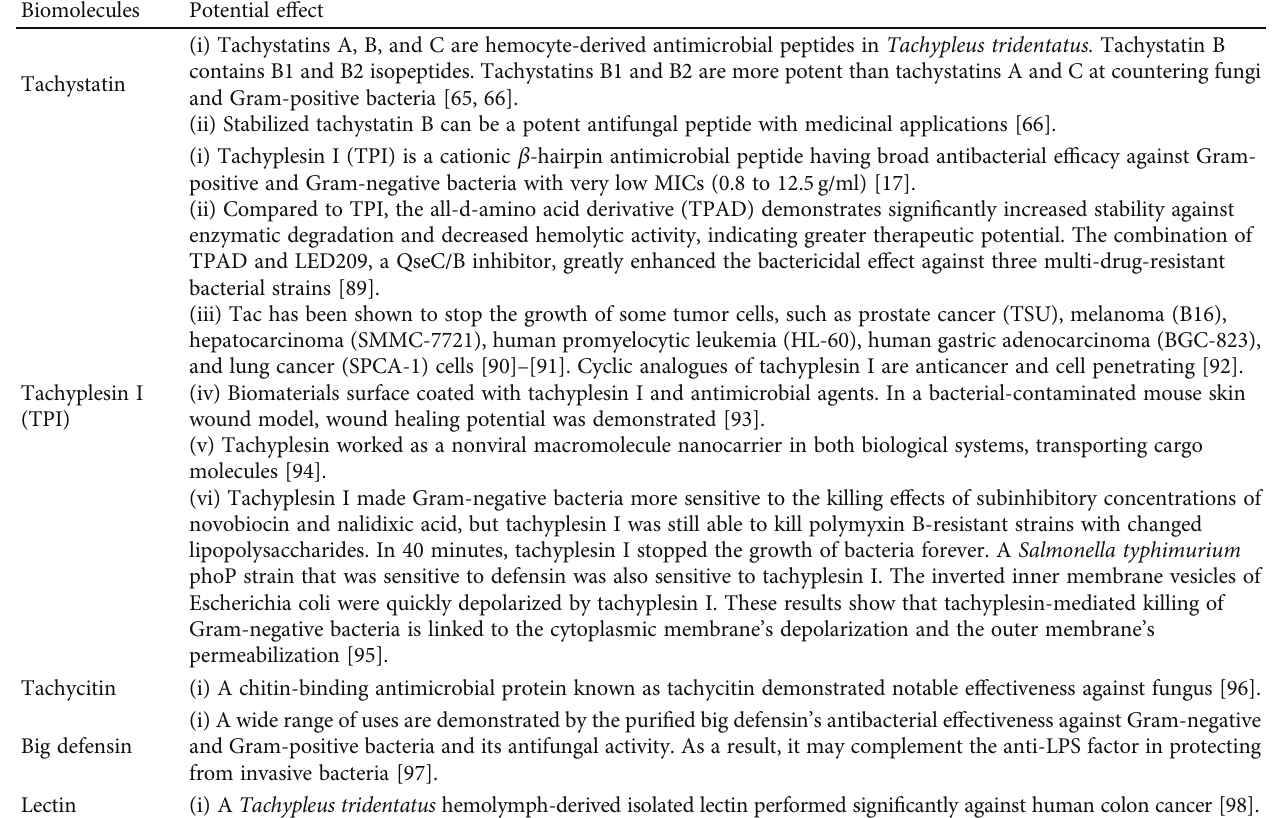
Table 5: Potential drug, antibiotics, and therapeutic e ff ect of hemolymph ’ s molecules of horseshoe crab.